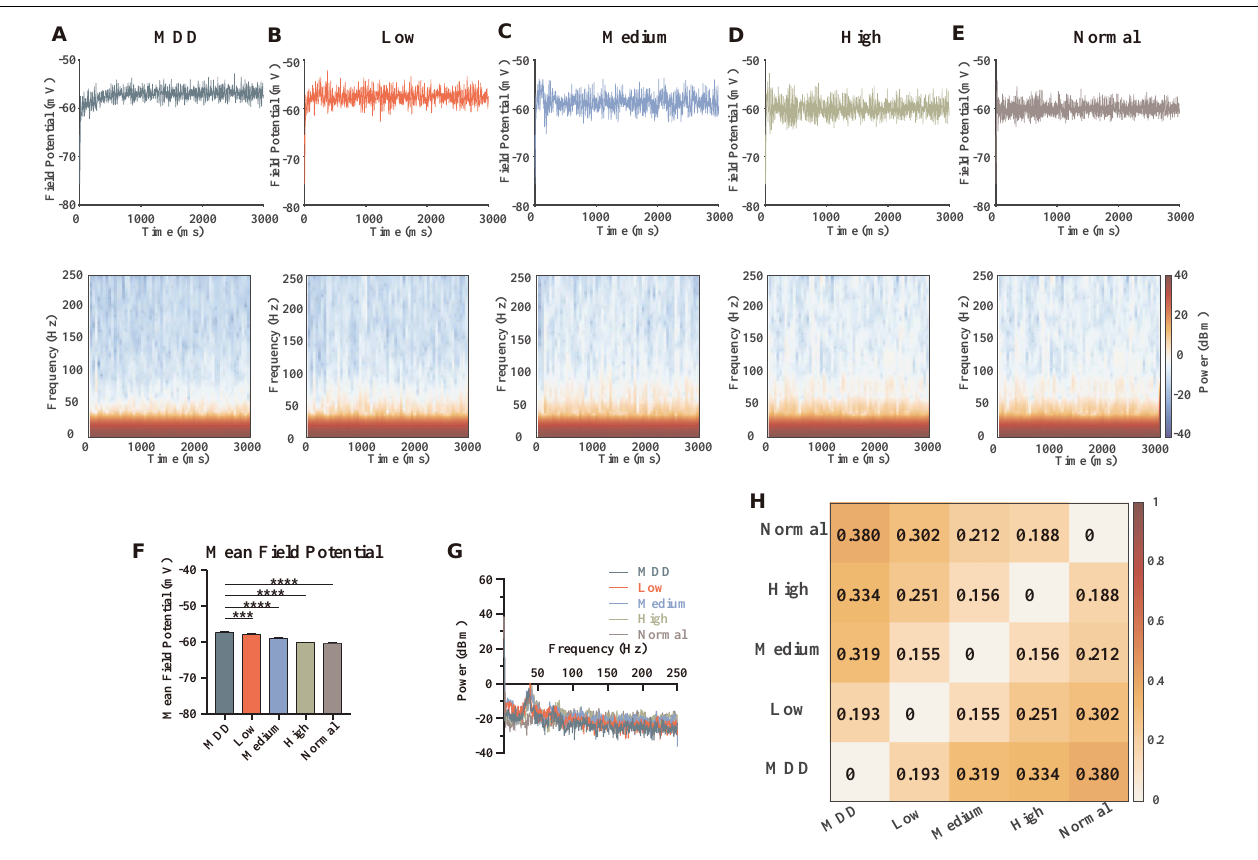
FIGURE 6 | Results and statistics of time-frequency analysis at different dopamine concentrations. (A–E) Local field potentials and mean time-frequency results of different dopamine concentrations, MDD (0%), Low (25%), Medium (50%), High (75%), and Normal (100%), with the same connection strengths and stimulus currents ( n = 6). (F) Statistical results of mean local field potential ( n = 6, Brown-Forsythe and Welch One-Way ANOVA). (G) Plots of the mean power spectral densities results of local field potentials for different concentrations of dopamine. (H) Heatmap quantification for time-frequency results of different concentrations, calculated as described in section “Materials and Methods” (spectral analysis). All the statistically significant differences were visualized in the graph. *** p < 0.001, **** p < 0.0001 means ±